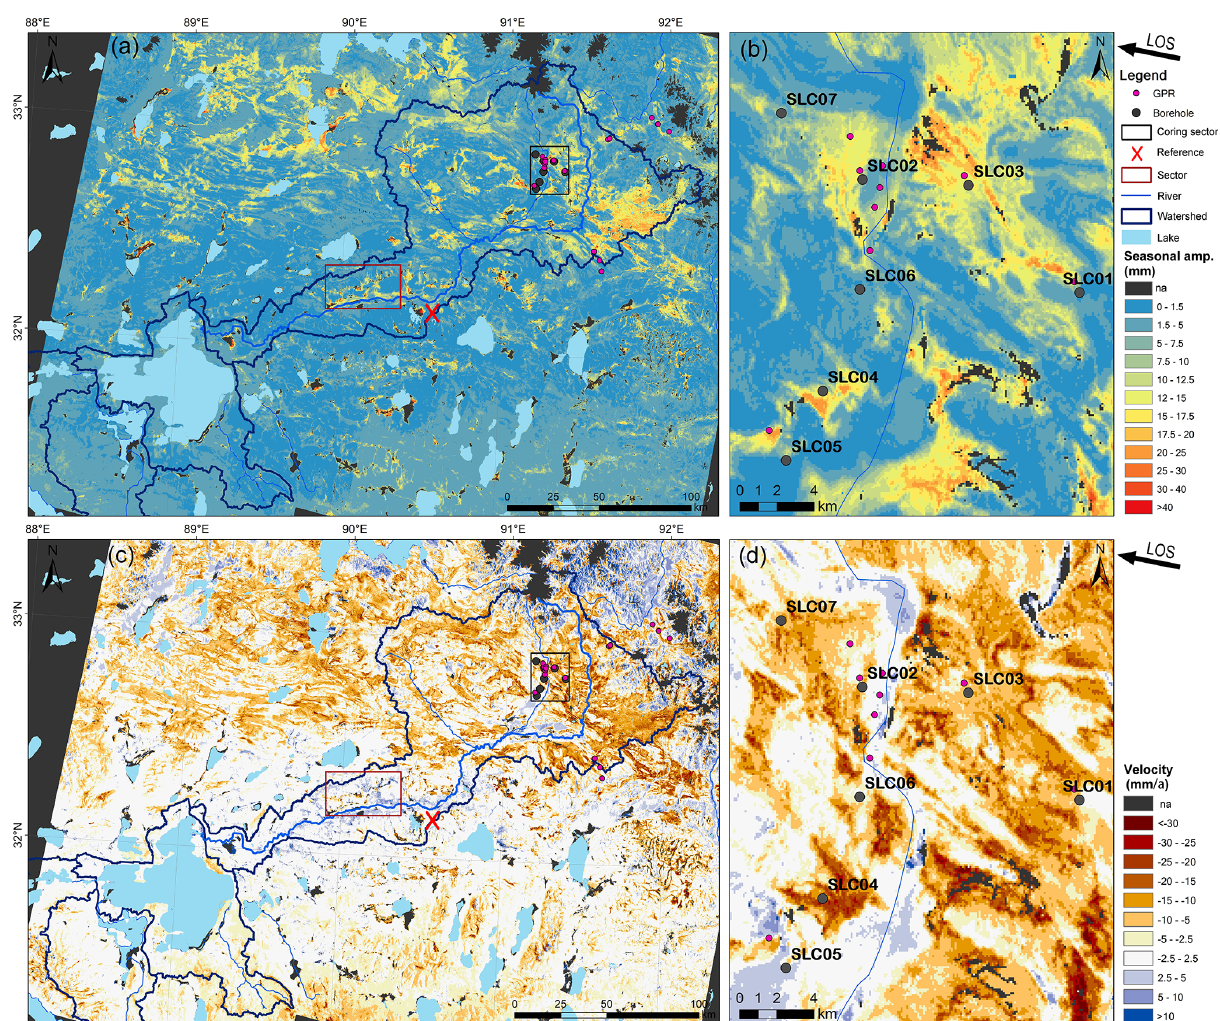
Figure 6. (a, b) Maps of the periodic (seasonal) amplitude and (c, d) maps of inter-annual deformation velocity, all in the satellite LOS direction. Panels (b) and (d) show an enlarged view of the coring area (black sector in panels a and c ). Dark-grey-colored “na” means the information could not be retrieved because of no data or decorrelation. Table 4. Characteristics of terrain subsidence in the Selin Co basin. Basin Average (mm) Percentage of subsidence (%) − 5 to − 2 . 5mm − 10 to − 5mm − 20 to − 10mm − 30 to − 20mm < − 30mm Zhajiazangbu subbasin − 10 .